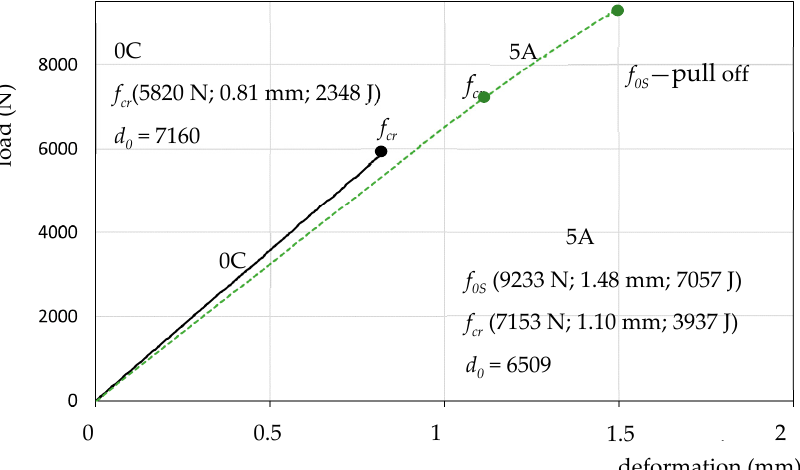
Figure 9. The load–deformation curve for specimen 5A and specimen 0C .